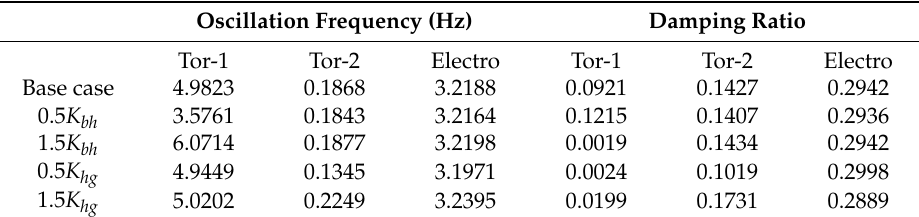
Table 5. Impact of the spring constants.